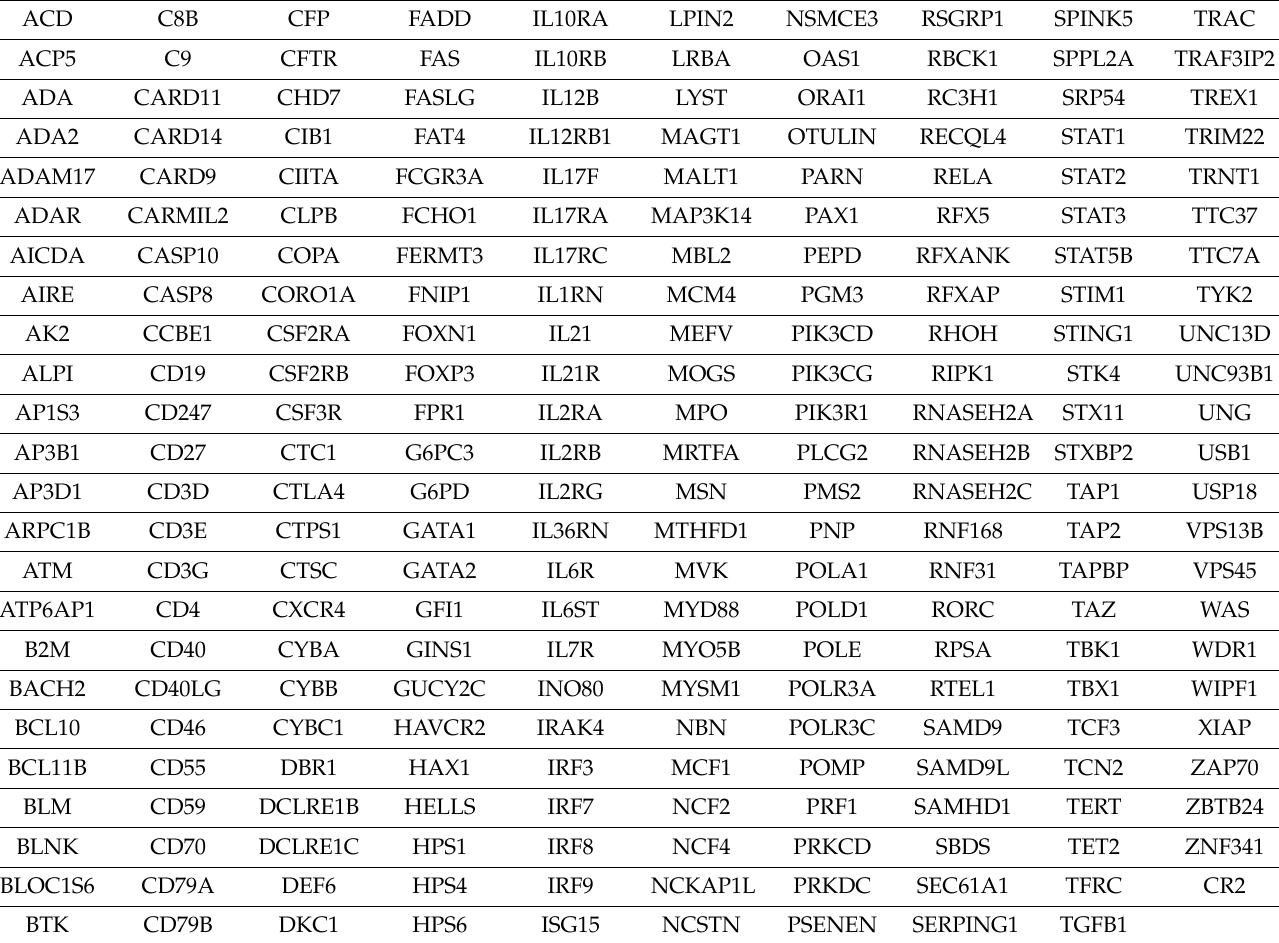
Table 3. Immunology exome sequencing of a panel of 356